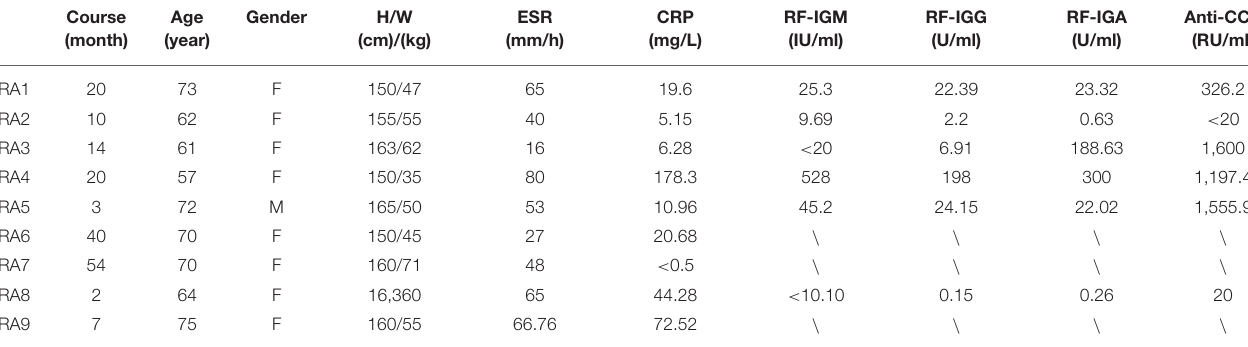
TABLE 1 | Demographic information of patients with rheumatoid arthritis